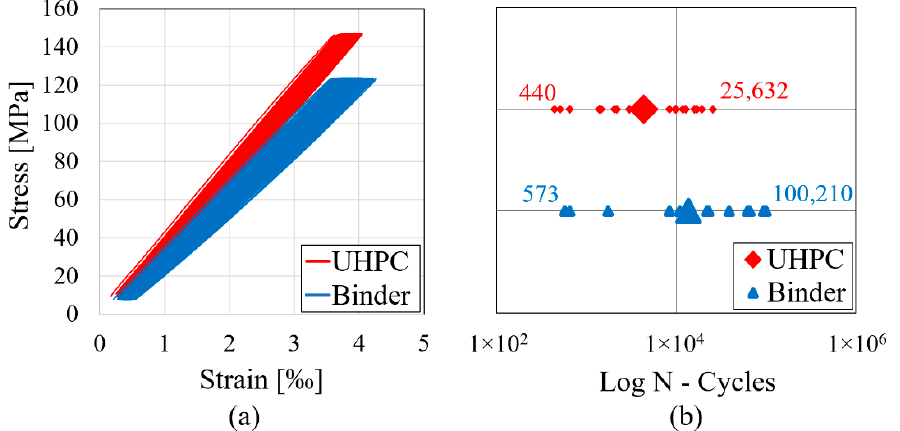
Figure 1. Results of experimental fatigue tests on UHPC and binder: ( a ) Typical stress–strain curves during fatigue; ( b ) Lifetime until fatigue failure (mean and single values).